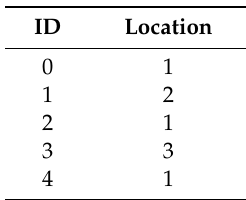
Table 3. Integer encoding of the toy dataset.